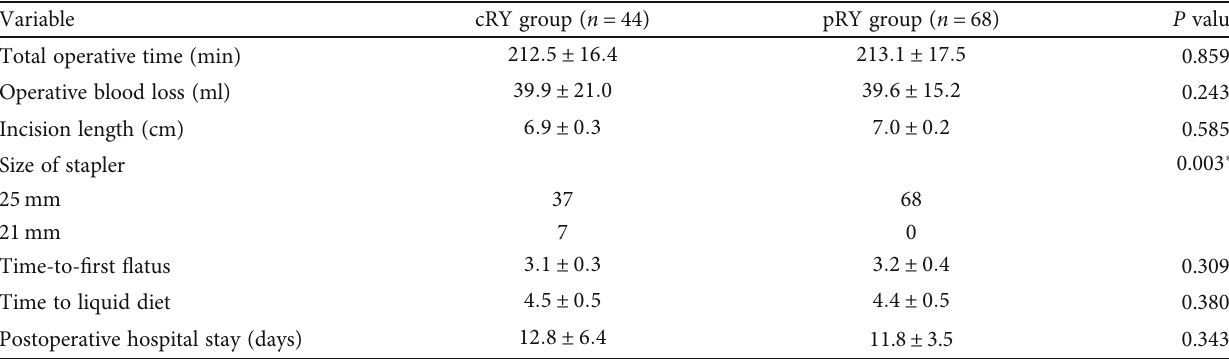
Table 2: Surgical outcomes in the cRY group and the pRY group.